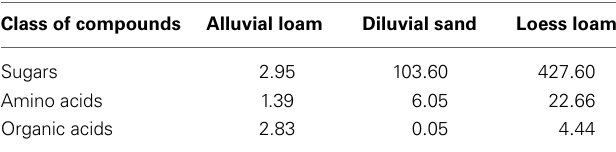
Table 4 | Amounts of sugars, amino acids, and aliphatic organic acids in root exudate samples collected from 2-cm sub-apical root zones of different soils (calculations based on cumulative peak area after subtraction of background levels in bulk soil samples).